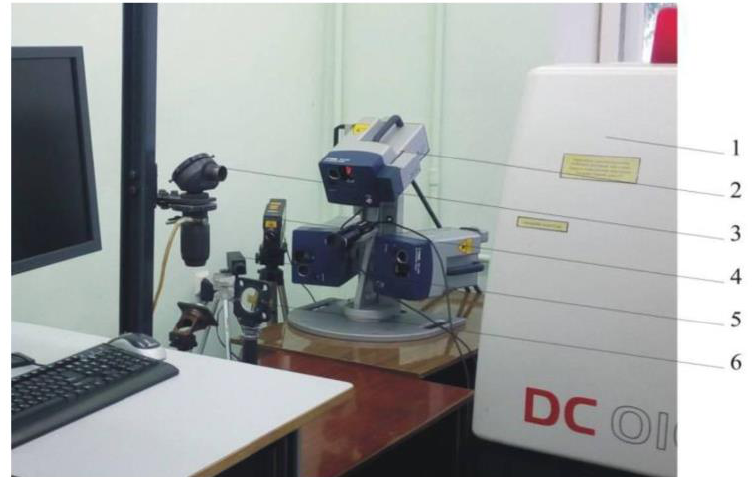
Figure 8. Setup for investigating the vibration characteristics: 1 — diffusion-cooled and radio-fre- quency excited CO 2 laser; 2 — three-axis scanning laser vibrometer; 3 — optical system; 4 — two-coordinate measuring instrument; 5 — non-contact thermometer; 6 — brass sample [147].